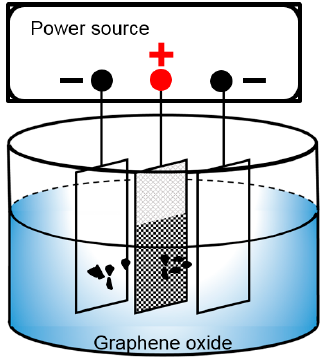
Figure 1. Schematic diagram of the EPD process.